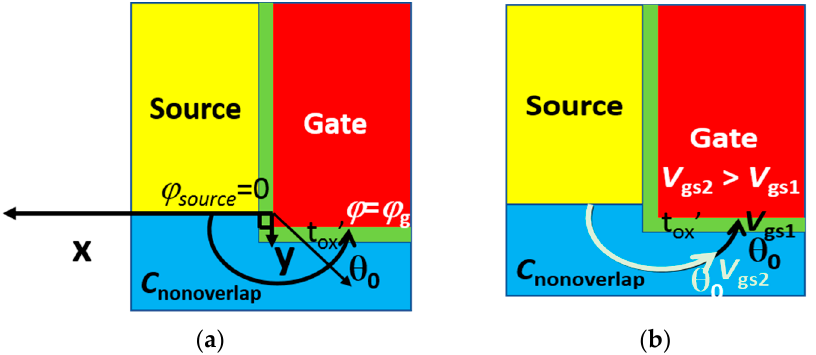
Figure 3. ( a ) Schematic illustrating the boundary conditions and the assumptions used in the model. ( b ) Schematic showing θ 0 at a lower V gs bias, V gs1 (black), and at a higher V gs bias, V gs2 (white). Table 1. List of all the symbols specific to the two-dimensional (2D) model. Table 1. List of all the symbols specific to the two-dimensional (2D) model.